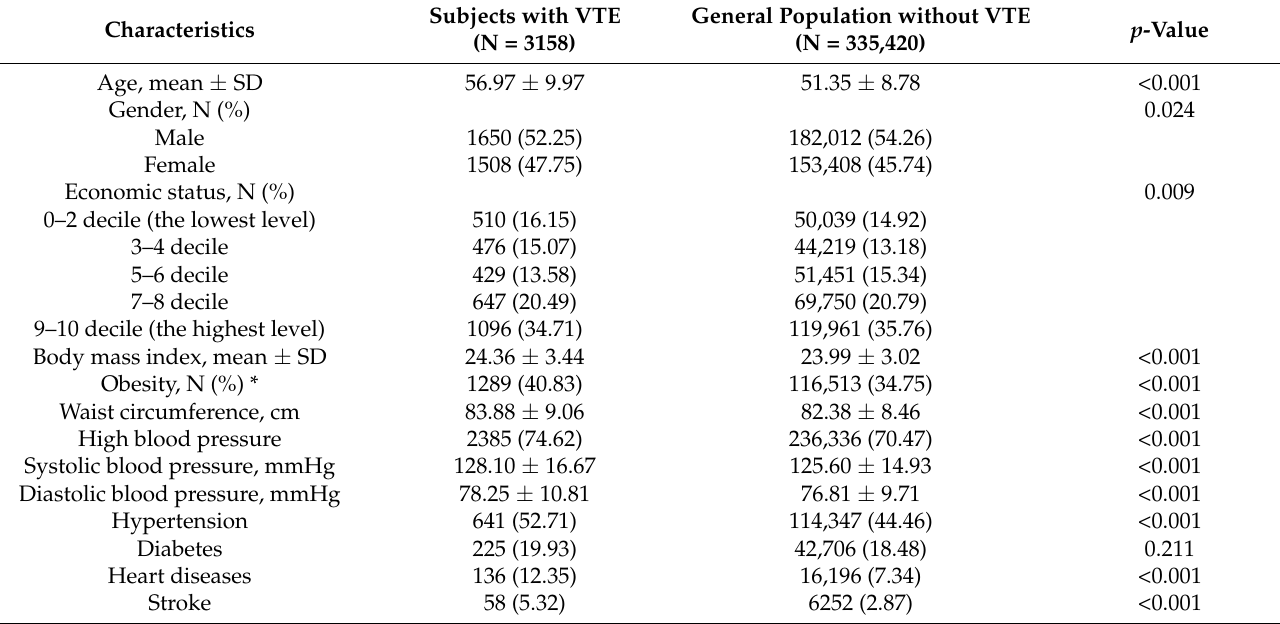
Table 1. Demographics of subjects with and without venous